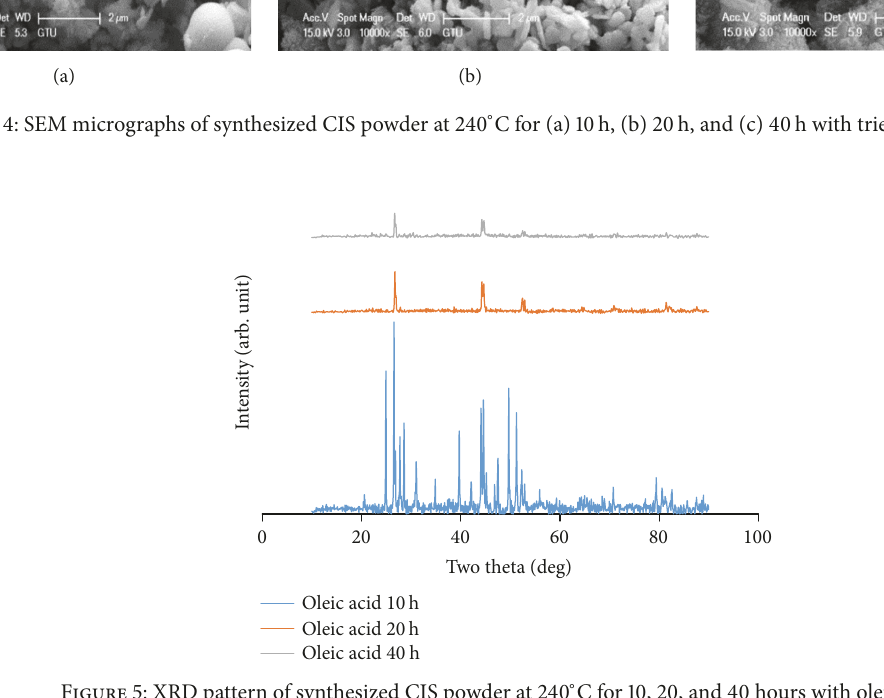
Figure 5: XRD pattern of synthesized CIS powder at 240 ∘ C for 10, 20, and 40 hours with oleic